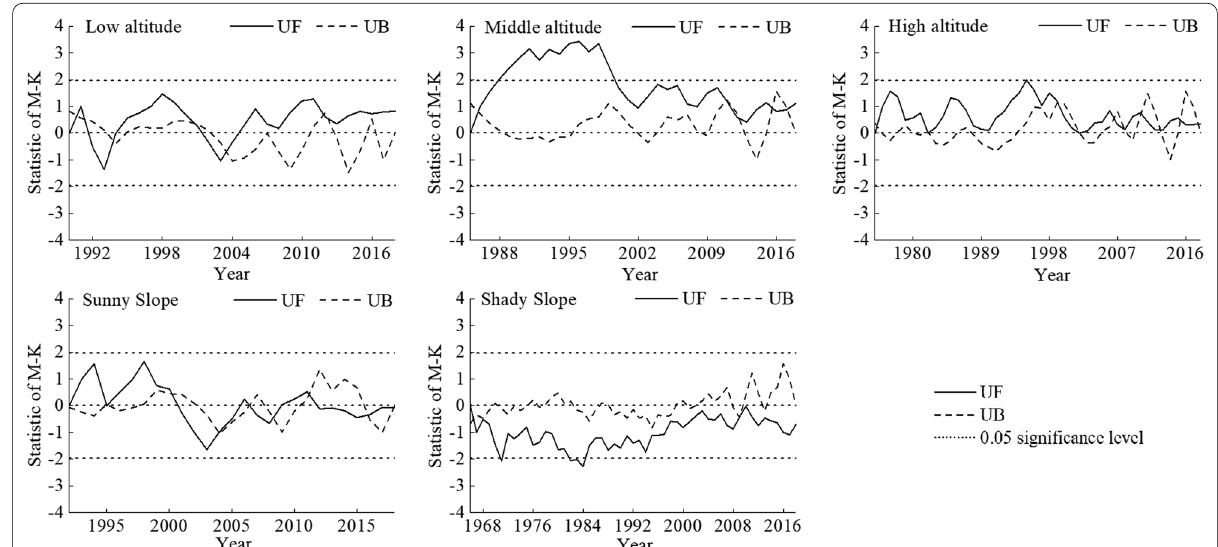
Fig. 6 Mann–Kendall mutation test curves of tree-ring width index with forward statistic UF (solid line) and backward statistic UB (dashed line) at the 0.05 significance level (dotted horizontal lines). The intersection of the UF and UB curves is located between the critical lines, corresponding to the time the mutation